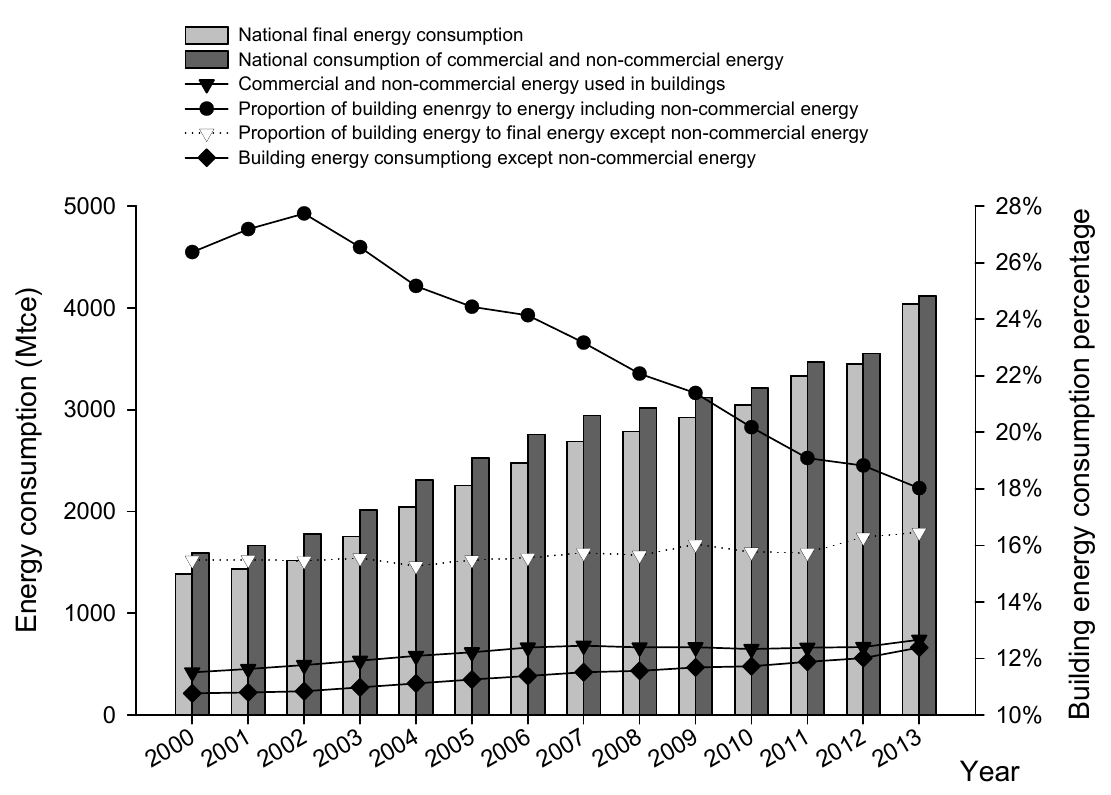
Figure 8. Energy consumption of buildings and its proportion in China